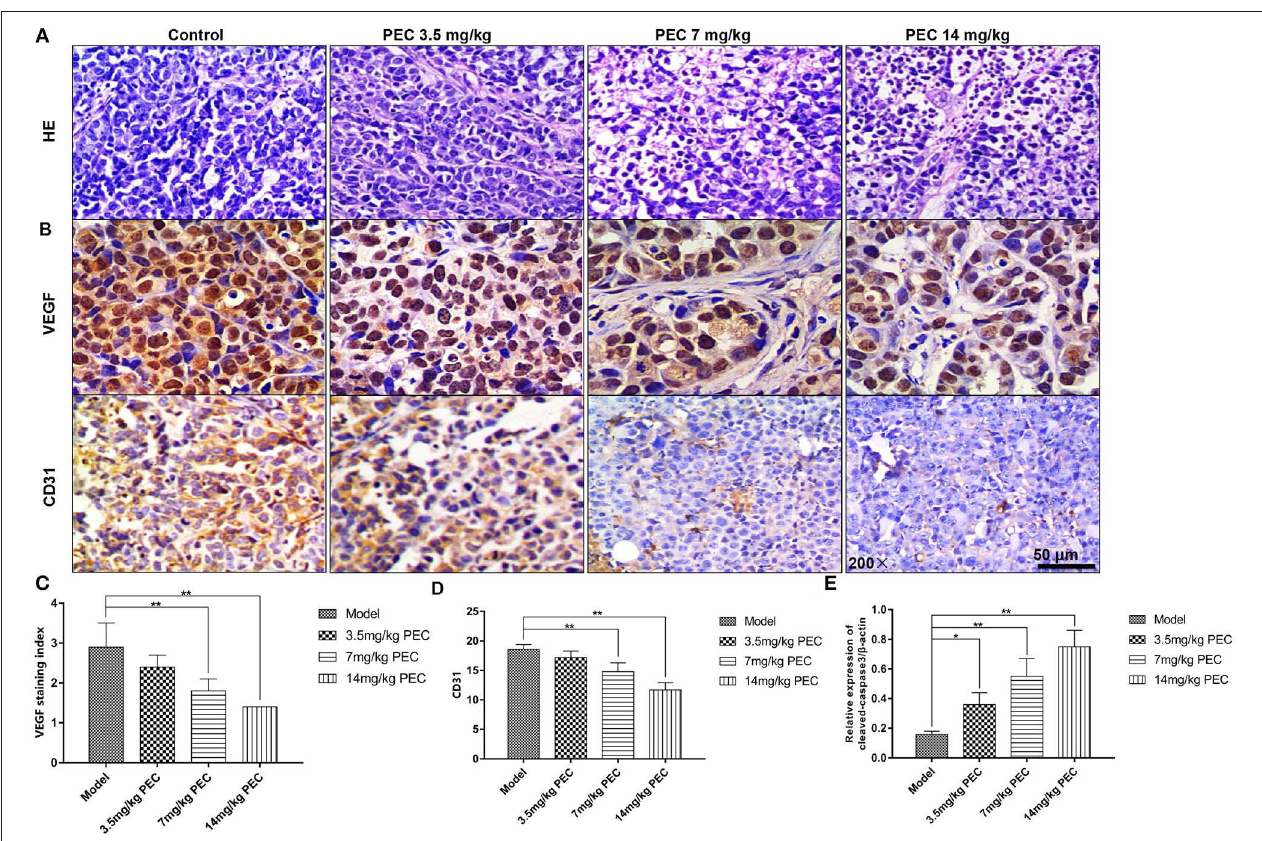
FIGURE 4 | Effects of PEC on tumor tissues (HE × 200) (A) and VEGF (B,C) and CD31 (B,D) expression in SGC-7901 tumor tissue (IHC × 200). The expression of cleaved-casease3/ β -actin in SGC-7901 tumor tissue (E) . Compared with model group: * P < 0.05, ** P <